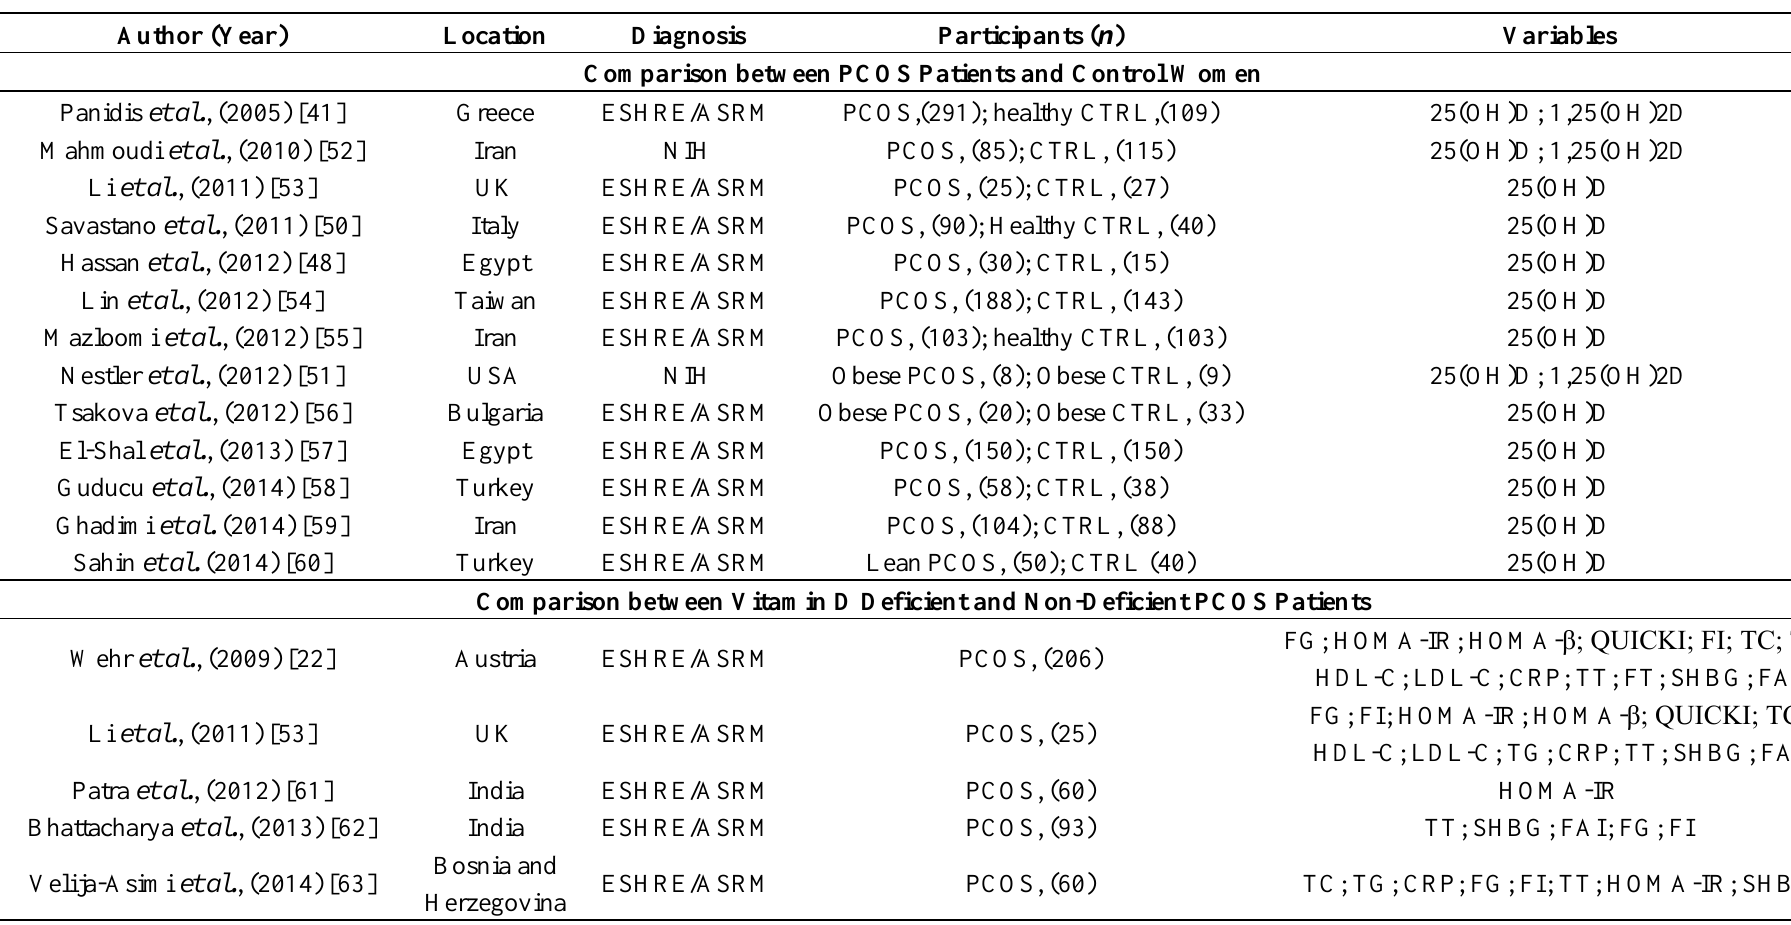
Table 1. Characteristics of included studies in the